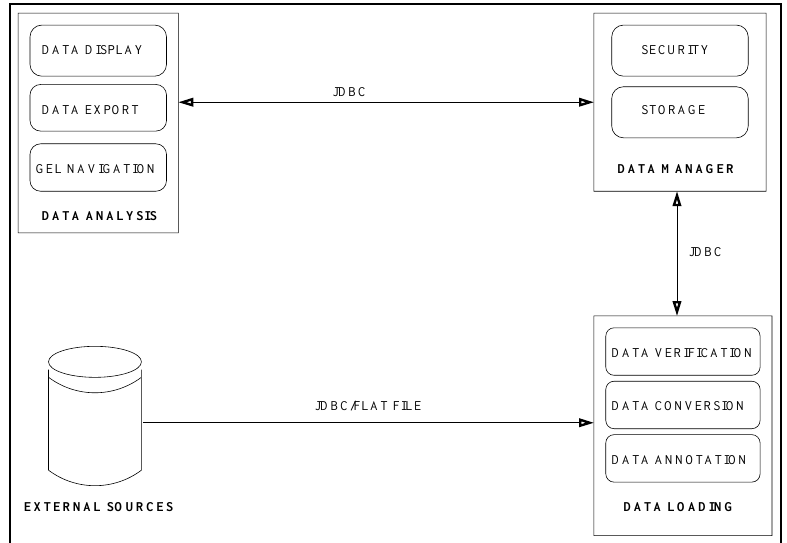
Figure 3: The architecture of the MS centered